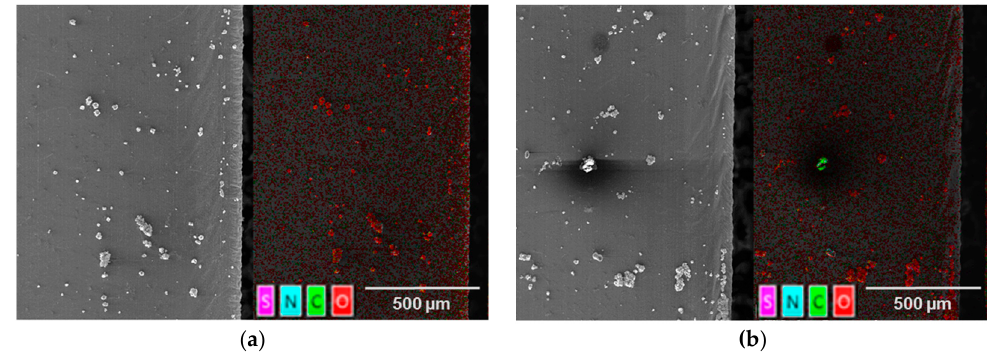
Figure 16. SEM (left) and EDX (right) section of a laser cut lithium sheet: 72.8 W, 490 kHz, 240 ns, dew point − 30 °C; ( a ) 50 mm/s; PO 99.89%; ( b ) 100 mm/s; PO 99.77%; after 5 months of aging in an atmosphere with a dew point of − 60 °C.